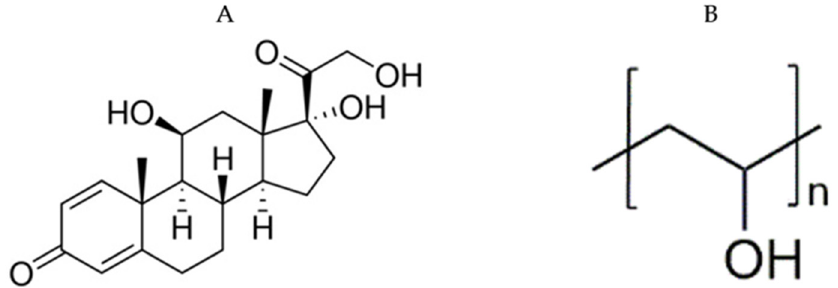
Figure 1. The chemical structures of: ( A ) prednisolone sodium phosphate (PSP) drug and ( B ) Polyvinyl alcohol (PVA). These structures were drawn by ChemDraw Professional 16.0.